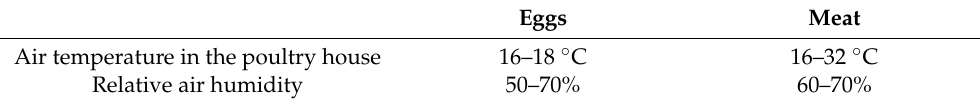
Table 1. Optimal temperature and humidity parameters for the air in poultry